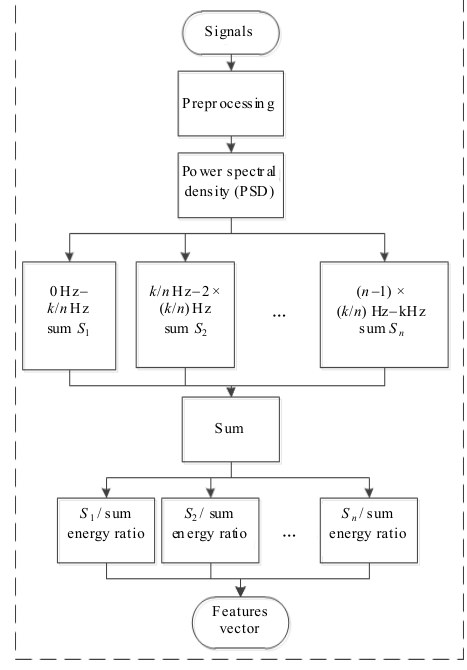
Fig. 2 Processing flow of energy ratio